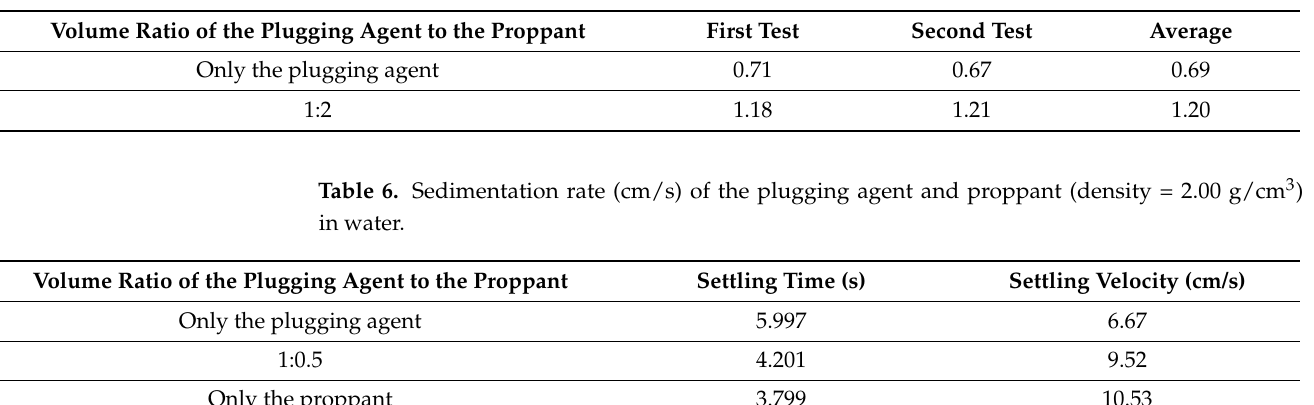
Table 5. Sedimentation rates (cm/s) of the plugging agent and proppant (density = 1.15 g/cm 3 ) in water.